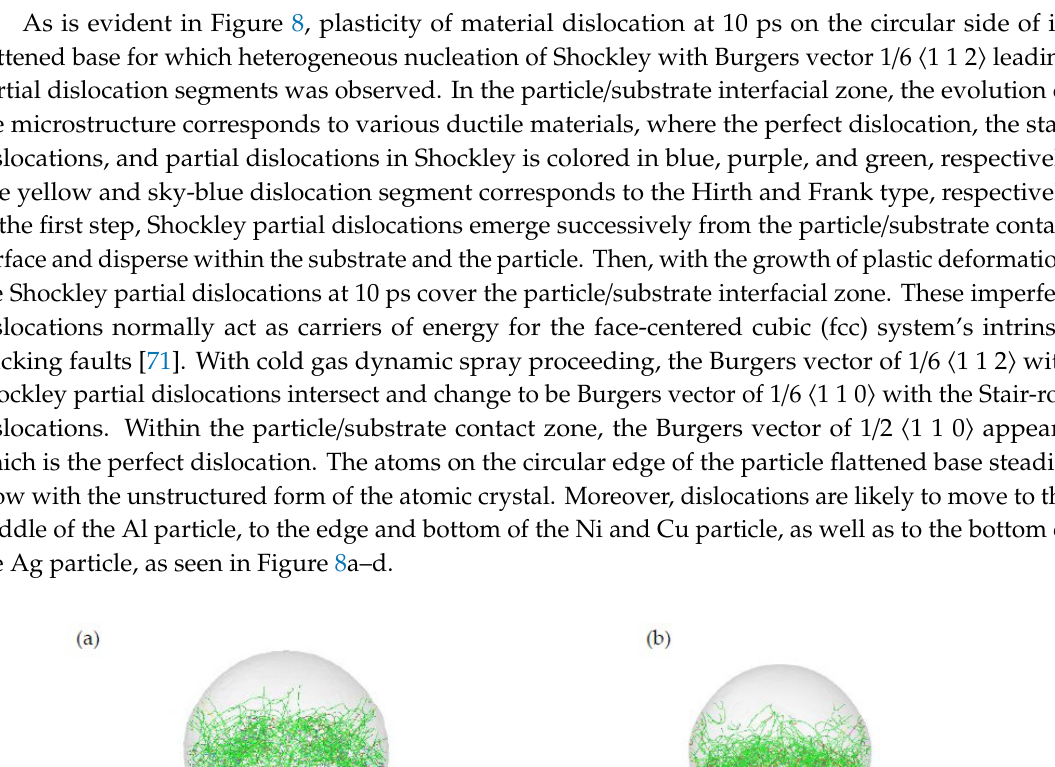
Figure 9. Cross-section view ( a1 – d1 ) and plan view ( a2 – d2 ) for the evolution of dislocation segment in the impacting particles of ( a1 , a2 ) Al/Cu, ( b1 , b2 ) Ni/Cu, ( c1 , c2 ) Cu/Cu, and ( d1 , d2 ) Ag/Cu after cold gas dynamic at 15 ps and 1000 m/s.